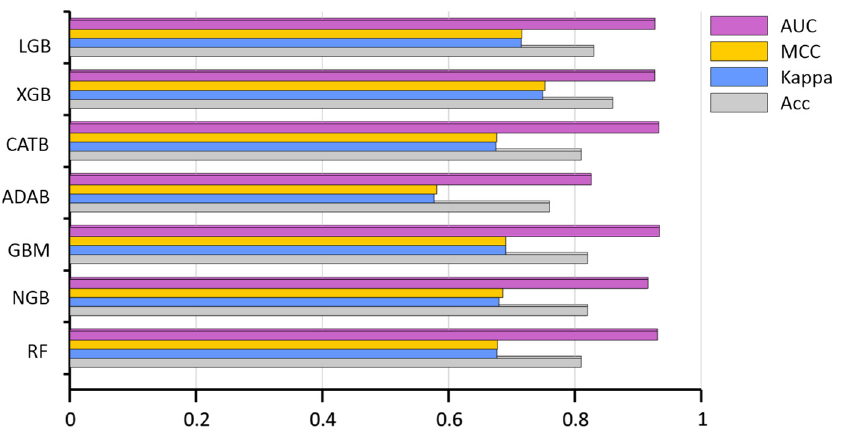
Figure 4. Overall performance evaluation of developed models using AUC, MCC, Kappa, and Acc.